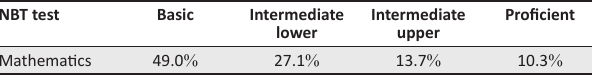
TABLE 3: Distribution across benchmark levels for 2013 national benchmark test mathematics candidates.